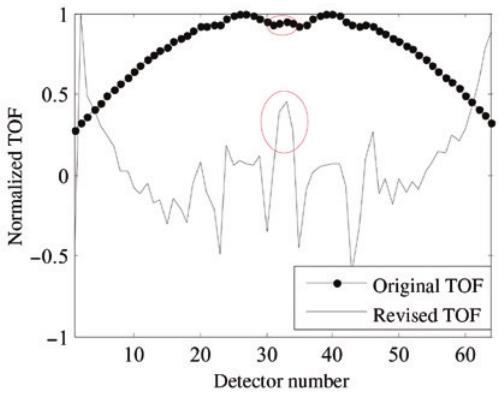
Figure 5: A set of the original normalized TOF data obtained from the flawed model with a hole in the center and the revised TOF data profile through the flaw